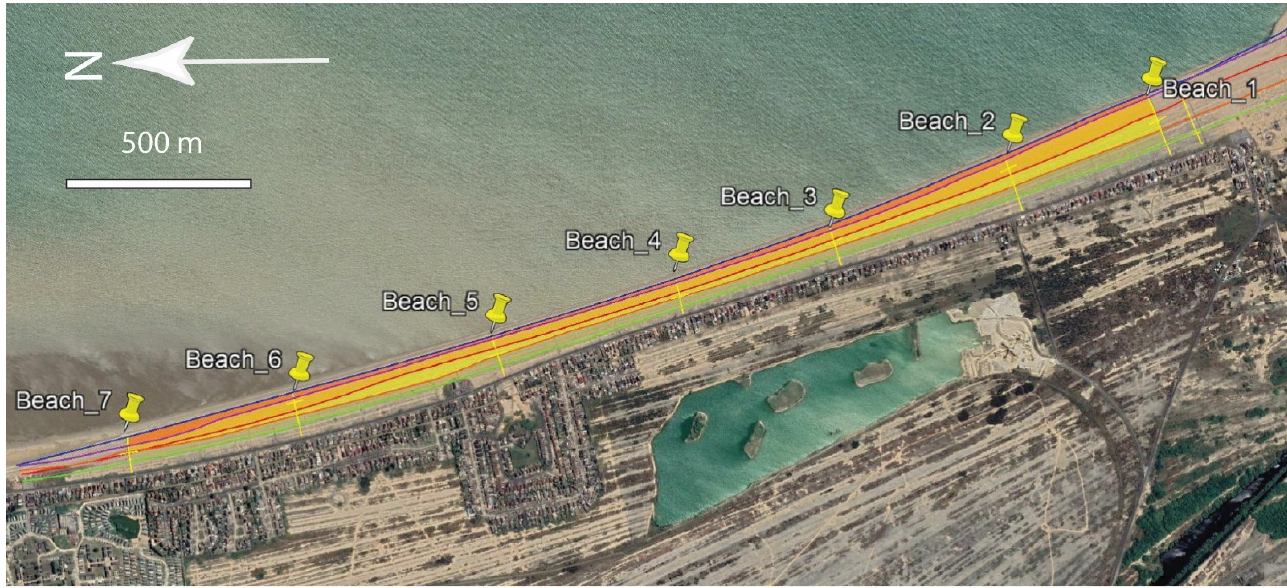
Figure 3. Google Earth image of the east-facing beach at Dungeness showing the location of the GPR profiles Beach 1–7 and locations of mapped shorelines from 1940 (green), 1960 (orange), 1990 (red), 2006 (purple), and 2019 (Blue).